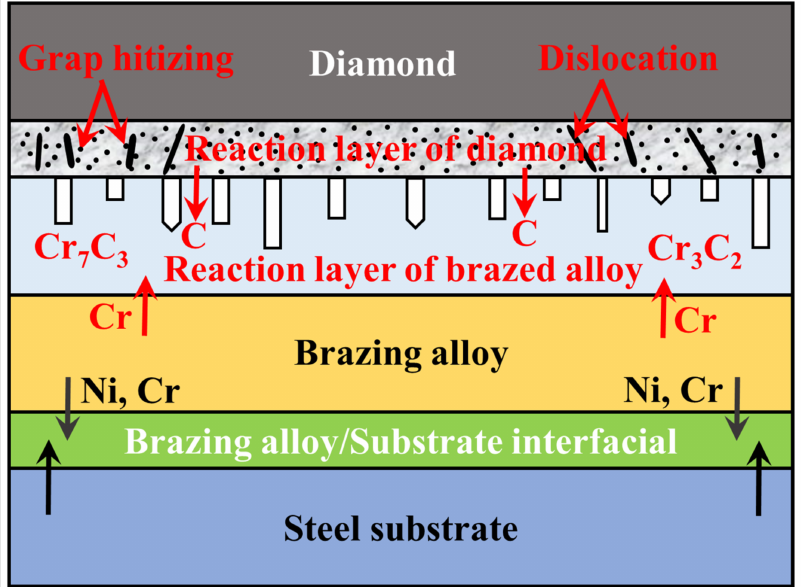
Figure 6. Schematic of diffusion mechanism model after brazing in the interface among diamond, brazing alloys, and steel